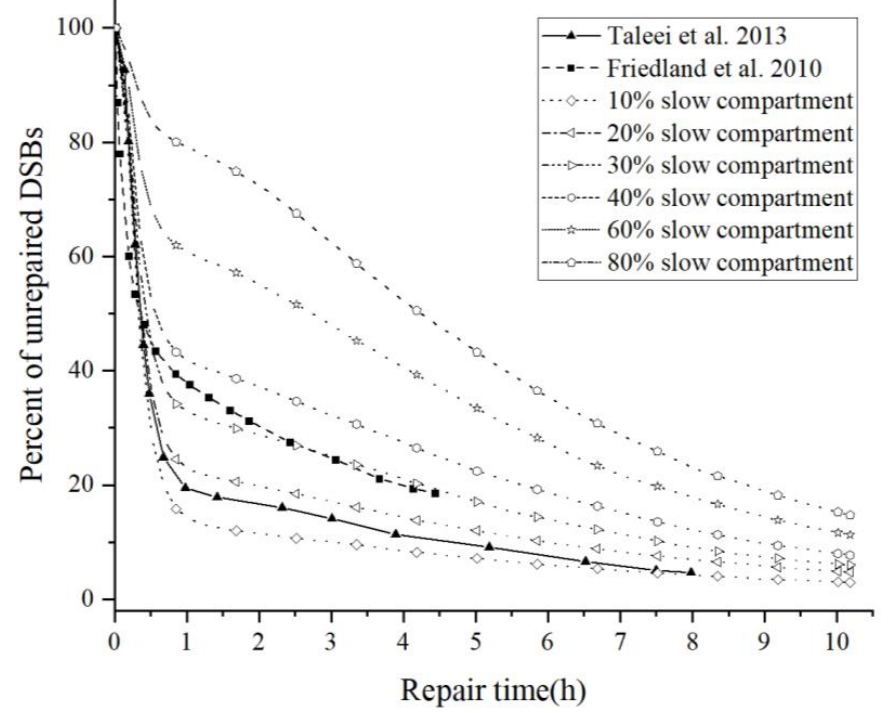
Figure 3. Repair curves of the repair models [21,33].